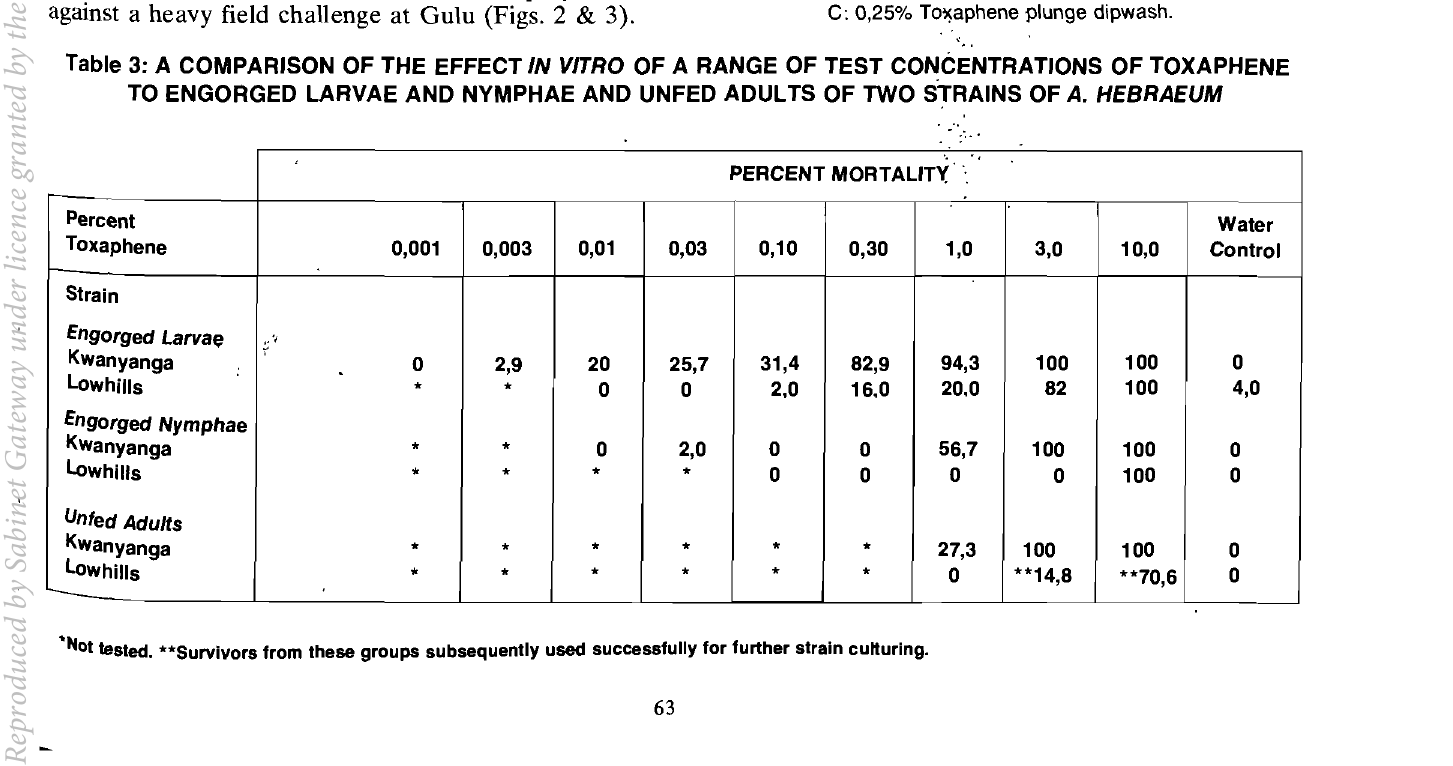
Table 3: A COMPARISON OF THE EFFECT IN VITRO OF A RANGE OF TEST CONCENTRATIONS OF TOXAPHENE TO ENGORGED LARVAE AND NYMPHAE AND UNFED ADULTS OF TWO STRAINS OF A.